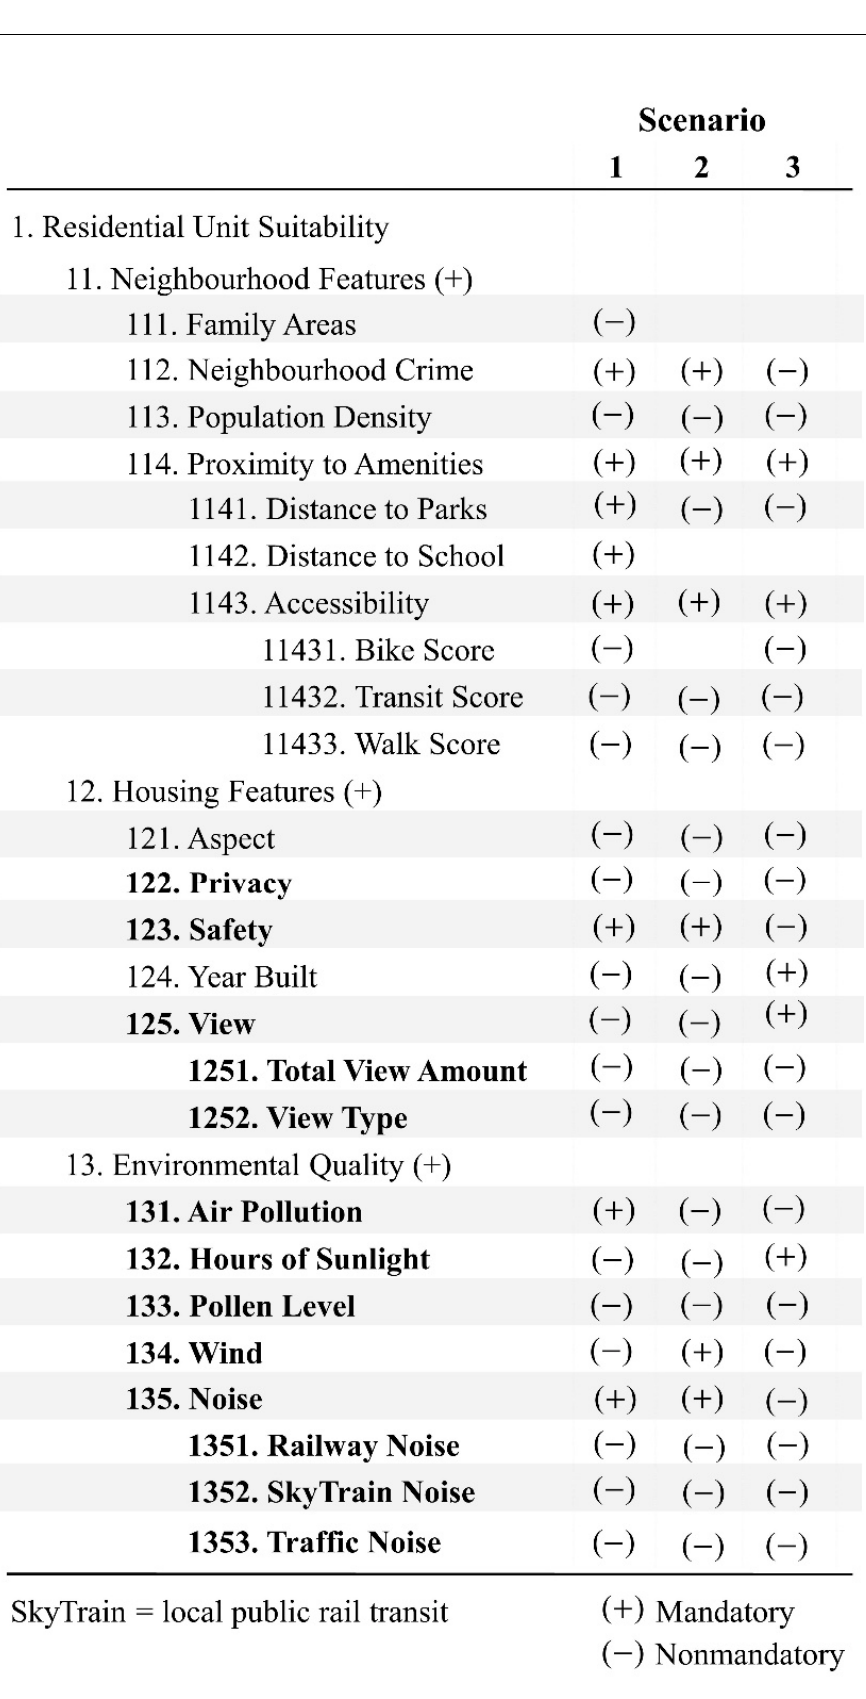
Figure 3. Attribute tree with elementary attributes for the three scenarios with 3D attributes high- lighted in bold text.